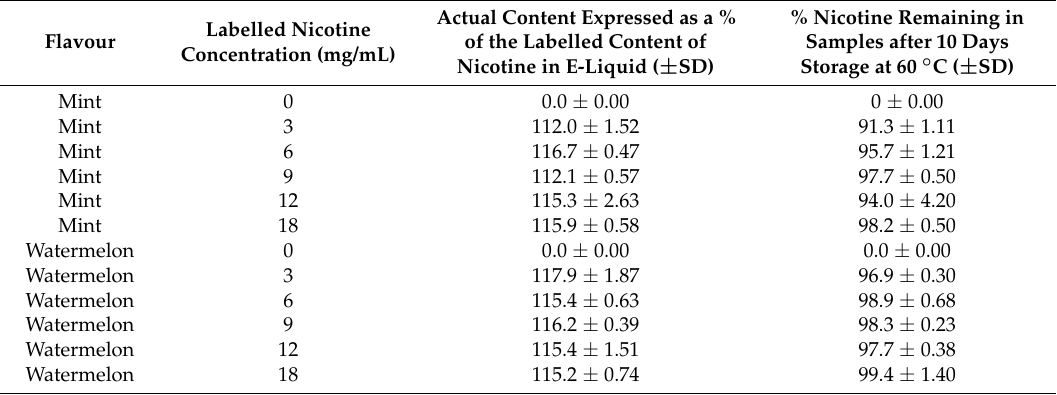
Table 4. Nicotine concentration analysis for standard and thermally stressed e ‐ liquids.